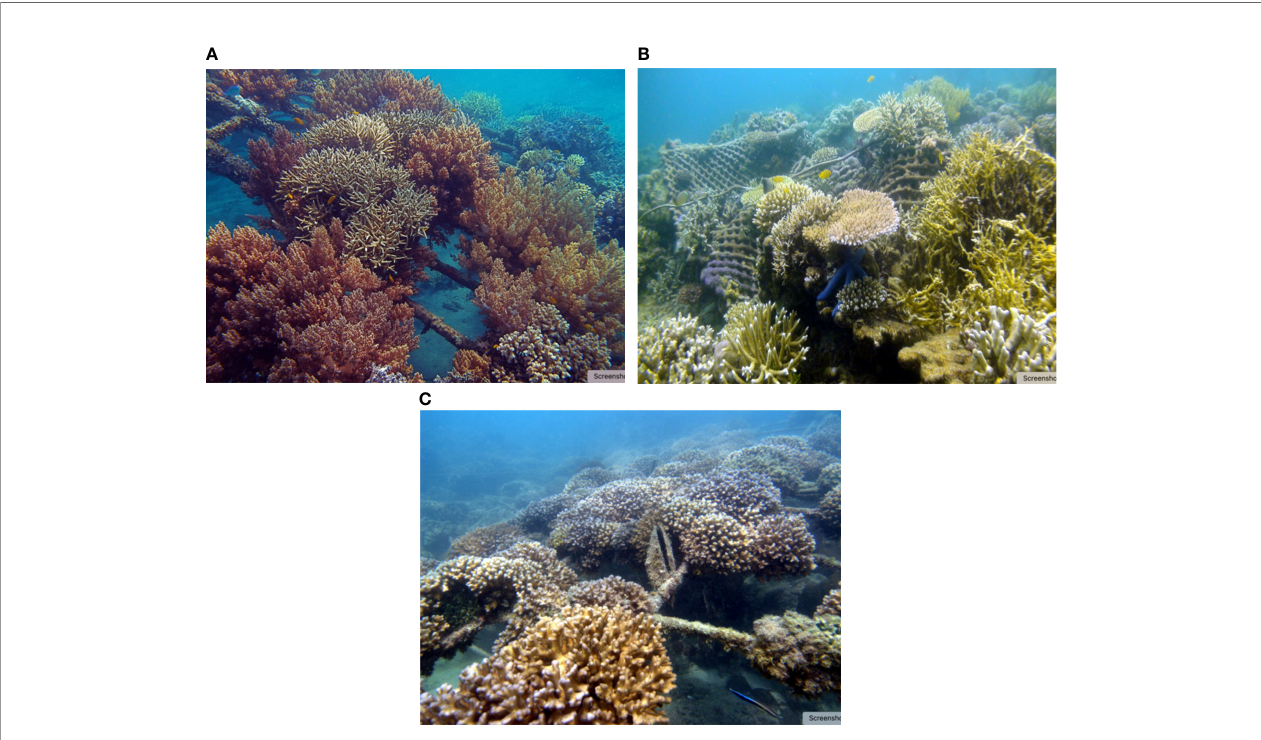
FIGURE 8 | (A) Most hard corals seen here were started from small fragments, but soft corals spontaneously settled over this Biorock reef in Pemuteran, Bali. Photograph by Rani Morrow Wuigk. (B) Corals quickly overgrow Biorock mesh that stabilizes dead coral rubble. Pemuteran, Bali. Many corals settled on the underside of the mesh and grew up through it. Photograph by Wolf Hilbertz. (C) Spontaneous settlement of corals and oysters on a two year old Biorock reef, Ko Samui, Thailand, photograph by Thomas